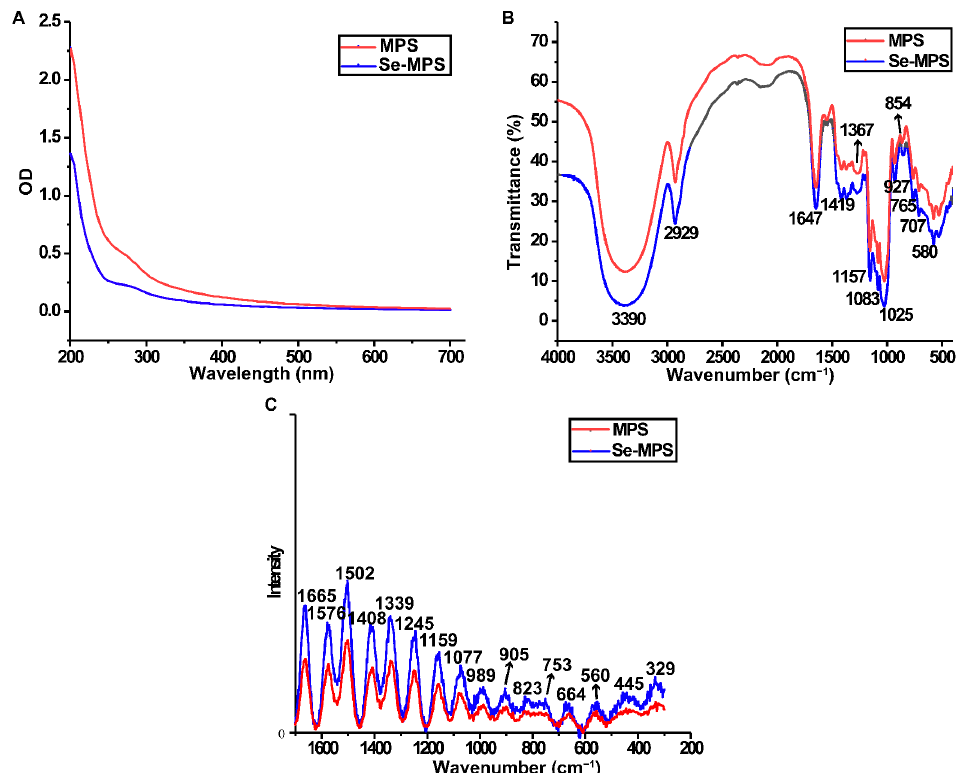
Figure 3. UV-vis ( A ), FT-IR ( B ), and Raman ( C ) spectra of MPS and